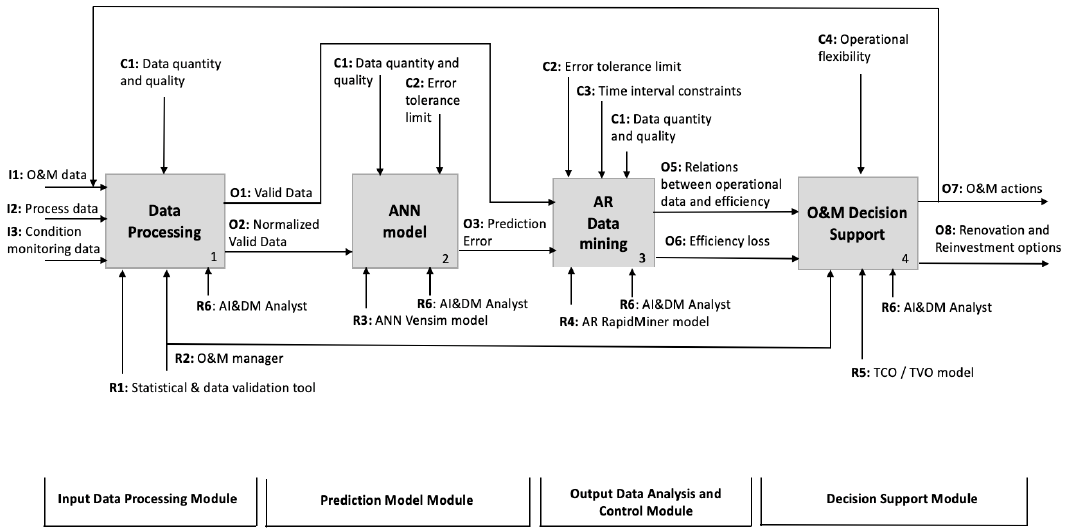
Figure 2. Level-1 representation of the asset performance monitoring and reliability assessment process.